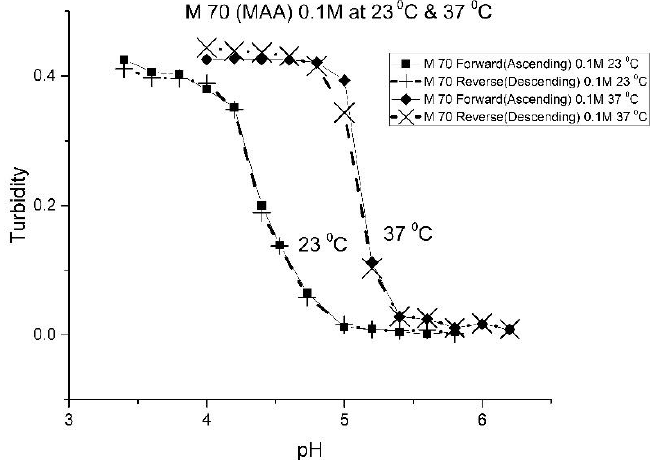
Figure 2. Ascending and descending pH profiles of polymer particles of M-70 (NIPA copolymerized with MAA) at 23 °C and 37 °C. Solid line = ascending pH profile. Dashed line = descending pH profile.